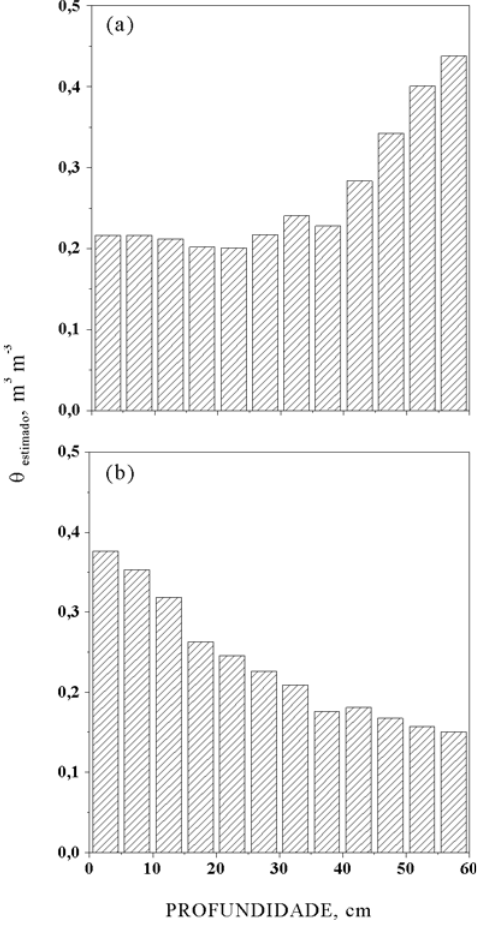
Figura 6. Valores da umidade do solo em campo para o Neossolo Quartzarênico órtico (a) e Latossolo Vermelho distroférrico (b), ambos de São Carlos, obtidos com a sonda espiral de TDR adaptada a um penetrômetro e medidos com o equipamento